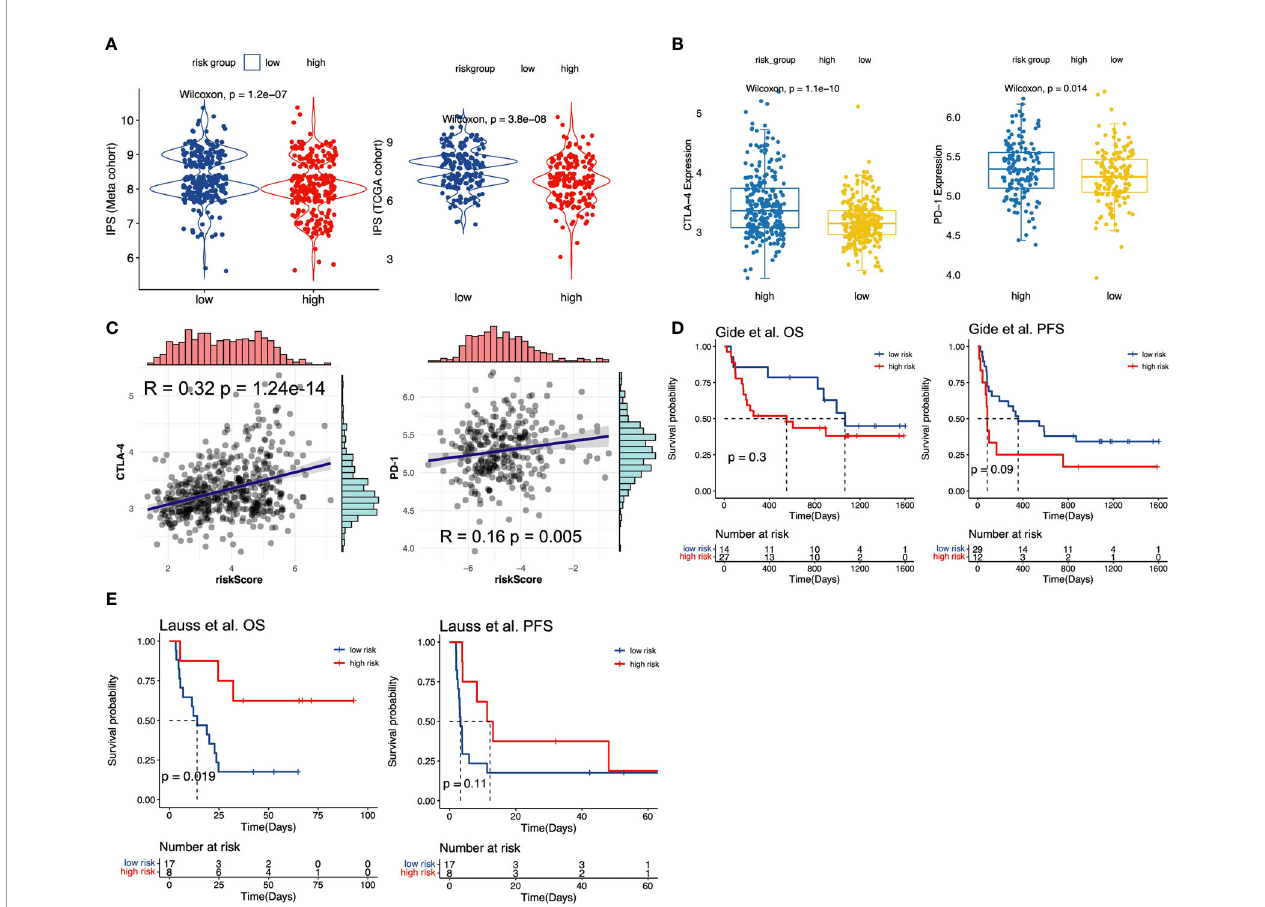
FIGURE 6 | The value of m 6 A-predictive score to predict patients ’ clinical outcomes with immunotherapy. (A) Comparison of IPS scores between low and high m 6 A-score groups in meta-GEO and TCGA cohorts. (B) The distribution of CTLA-4 expression levels between low and high m 6 A-score groups in meta-GEO cohort. The distribution of PD-1 expression levels between low and high m6A-score groups in GSE72094 cohort. (C) The Spearman correlation analysis of CTLA-4 and predictive score in meta-GEO cohort. The Spearman correlation analysis of PD-1 and predictive score in GSE72094 cohort. (D) Kaplan-Meier curves for low and high m 6 A-score groups in Gide et al. (49) cohort. (E) Kaplan-Meier curves for low and high m 6 A-score groups in Lauss et al. (50)